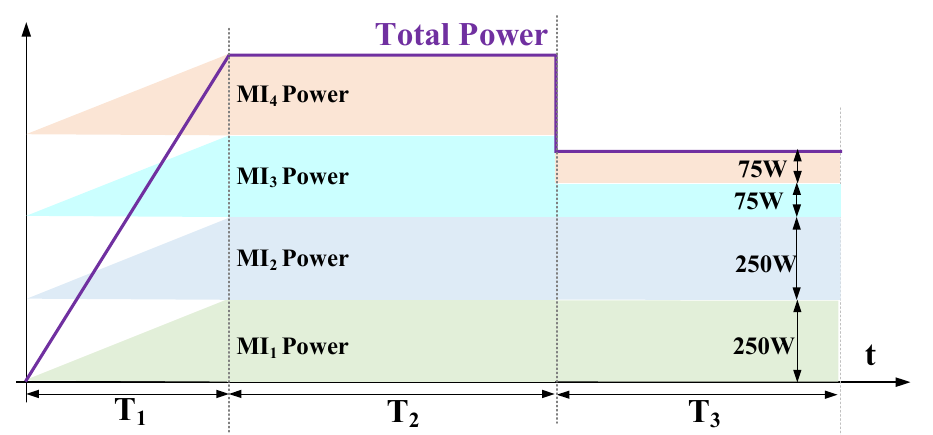
Figure 16. MCI, PV module, and system-level controllers for PV/grid DC/AC inversion.